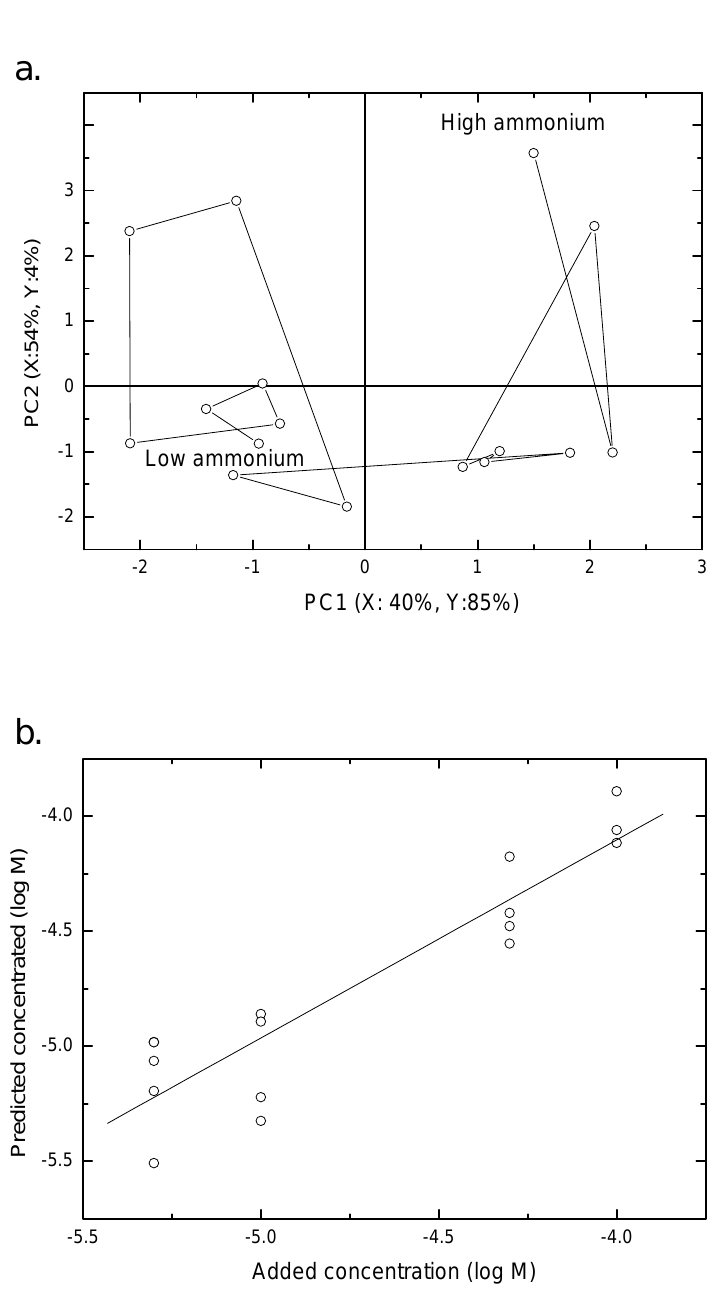
Figure 6. a: PLS-1 score plot for 16 samples of ammonium, considering limits of modelling in test mixtures of key odorants containing ammonium at pH 6. b: Calibration curve of identical ammonium samples. PLS-1, full cross validation and two PCs were used and six electrodes were